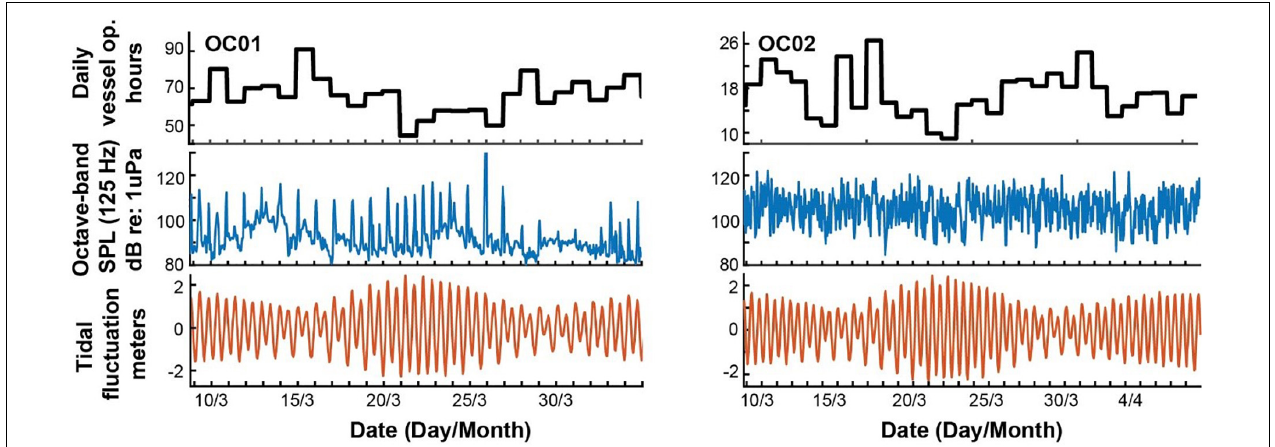
FIGURE 8 | Influence of artificial sound from tidal flow on measured sound levels. Top panels show daily vessel operating hours (calculated from AIS data as sum of time all vessels spent within a 10 km radius; note different y-axis scale), middle panels show 125-Hz octave band sound levels, and bottom panels show tidal fluctuation at two sites in Olympic Coast National Marine Sanctuary (OC01 and OC02).